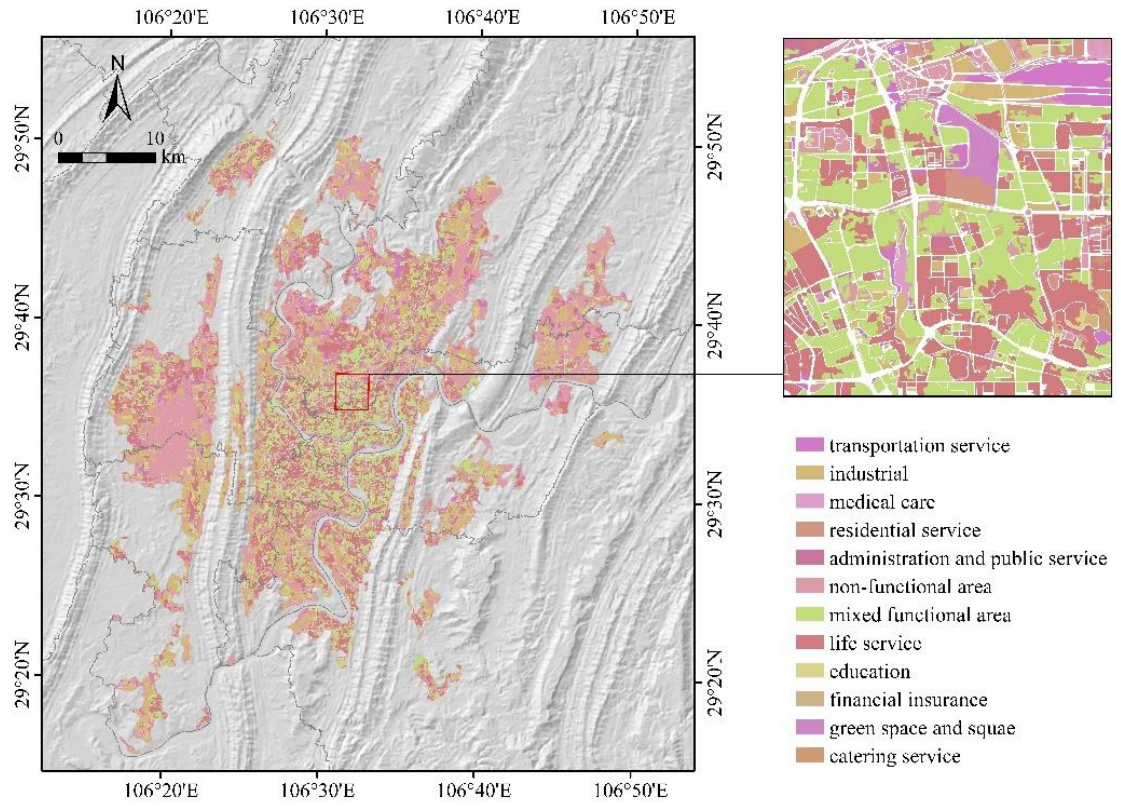
Figure 4. Functional area identification diagram.